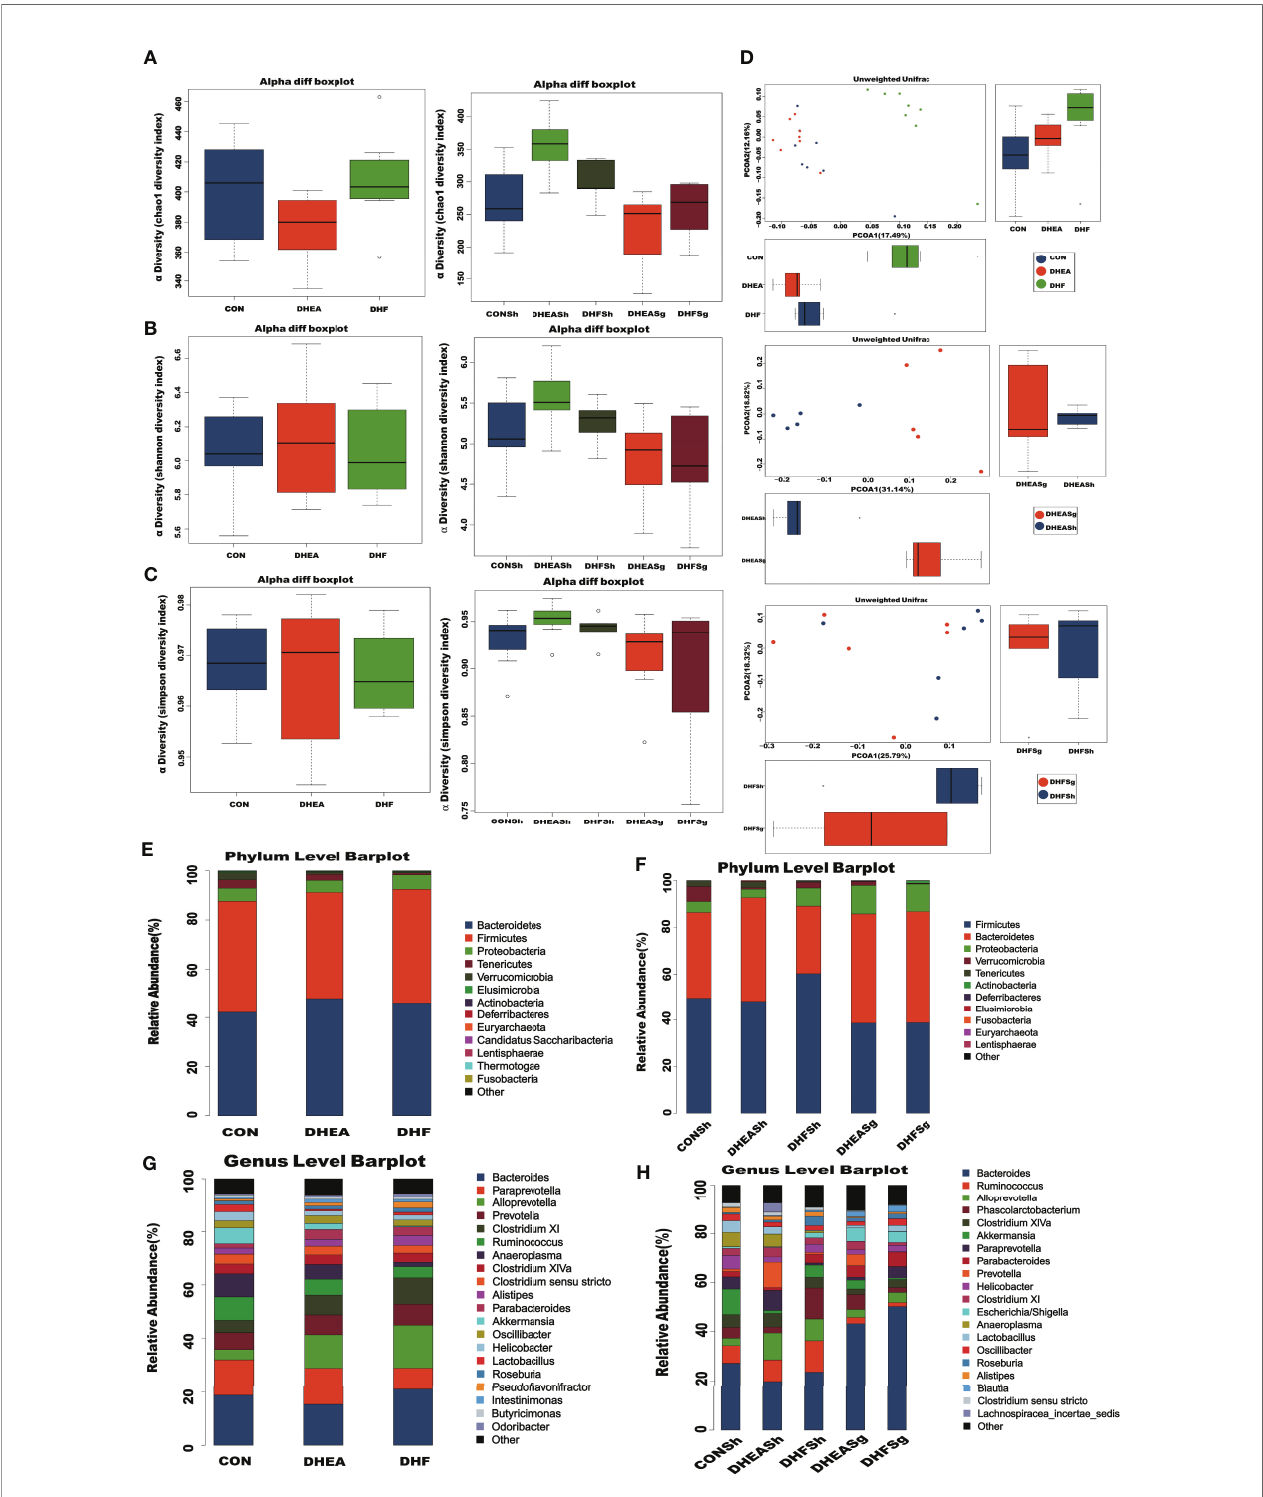
FIGURE 1 | Effects of SG on shifts in gut microbiota. (A) Chao1 diversity index. (B) Shannon diversity index. (C) Simpson diversity index. (D) b diversity analysis using Unweighted UniFrac ANOSIM analysis and principal coordinates analysis (PCA) of bacterial community composition using the unweighted UniFrac metric at the genus level. (E-H) Bar plot of the microbial community structure at the phylum level before (E) and after (F) surgery, and at the genus levels before (G) and after (H)